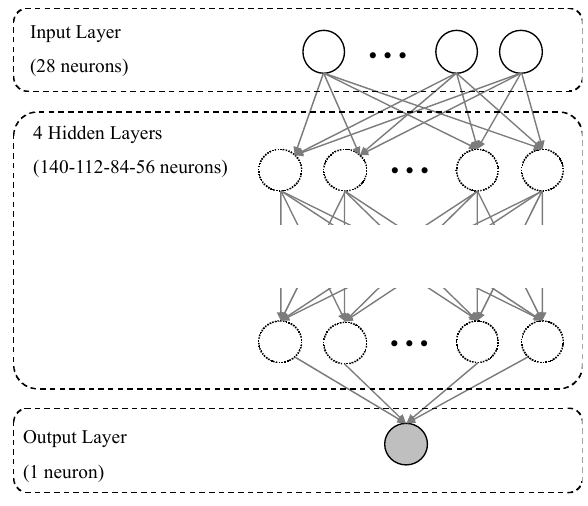
Figure 4. Structure of the pose-categorization model.